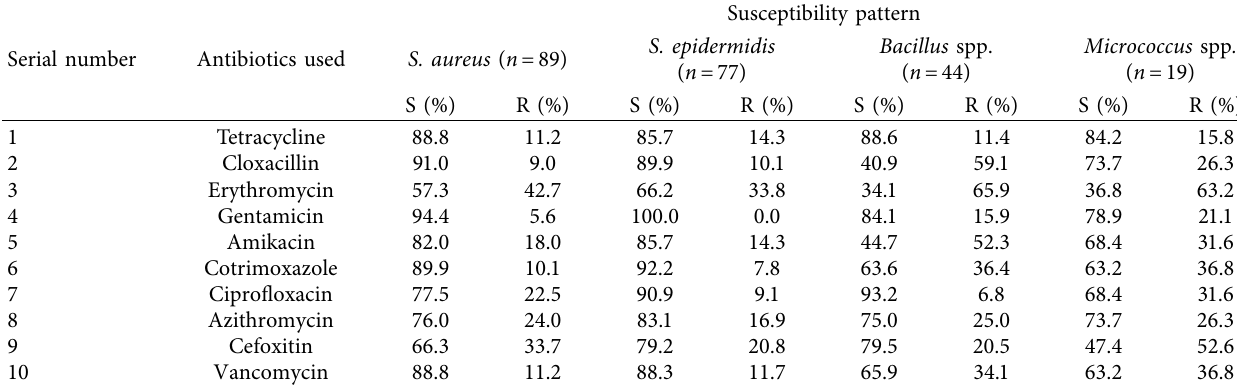
Table 4: Antibiotic susceptibility pattern of Gram-positive